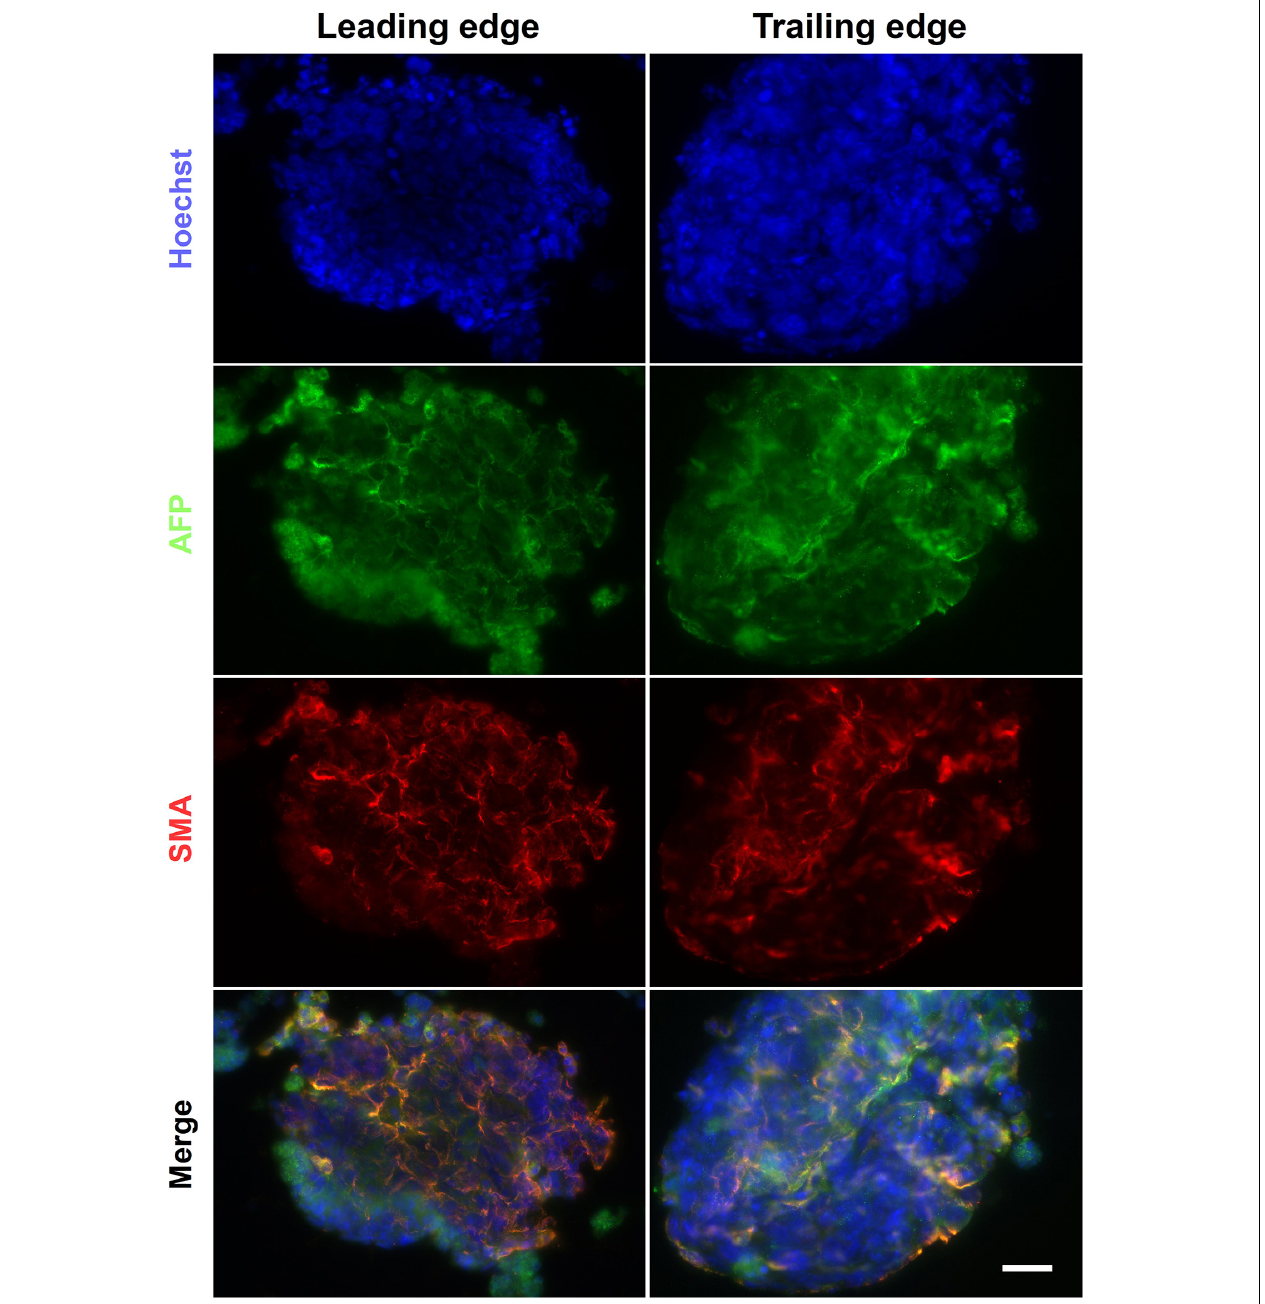
FIGURE 11 | Endoderm and mesoderm differentiation in alginate fibers. The alginate fibers contained markers of endoderm and mesoderm germ layers at day 6 of differentiation. These were present at both the trailing and leading end of the fiber. Scale Bar: 50 µ